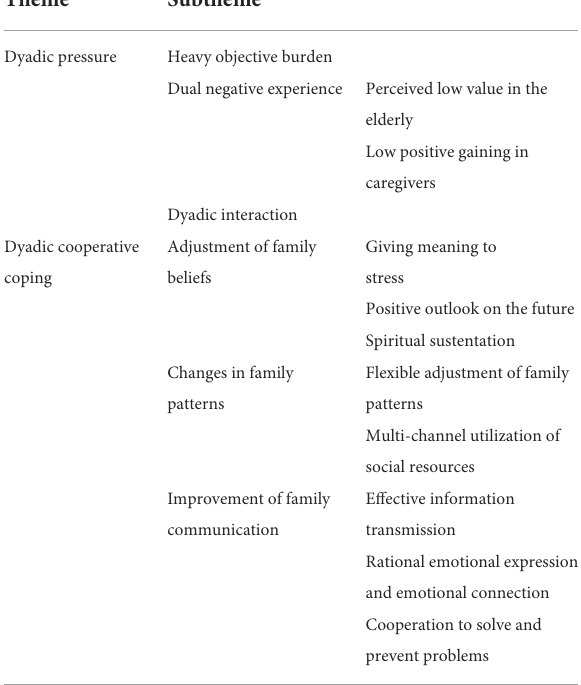
TABLE 2 Classification of theme and